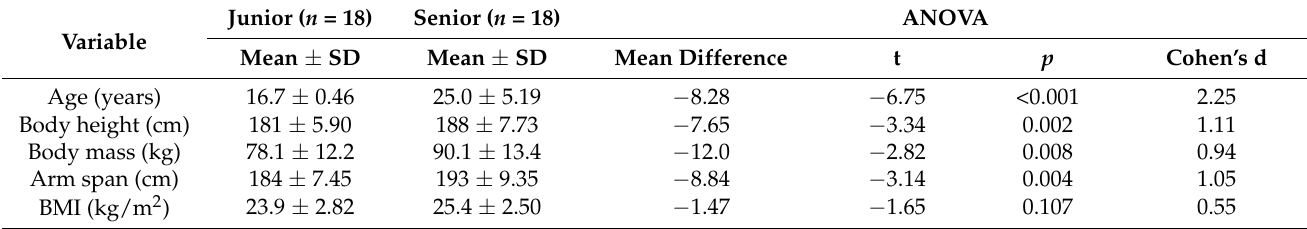
Table 1. Basic anthropometric and demographic characteristics of the sample.